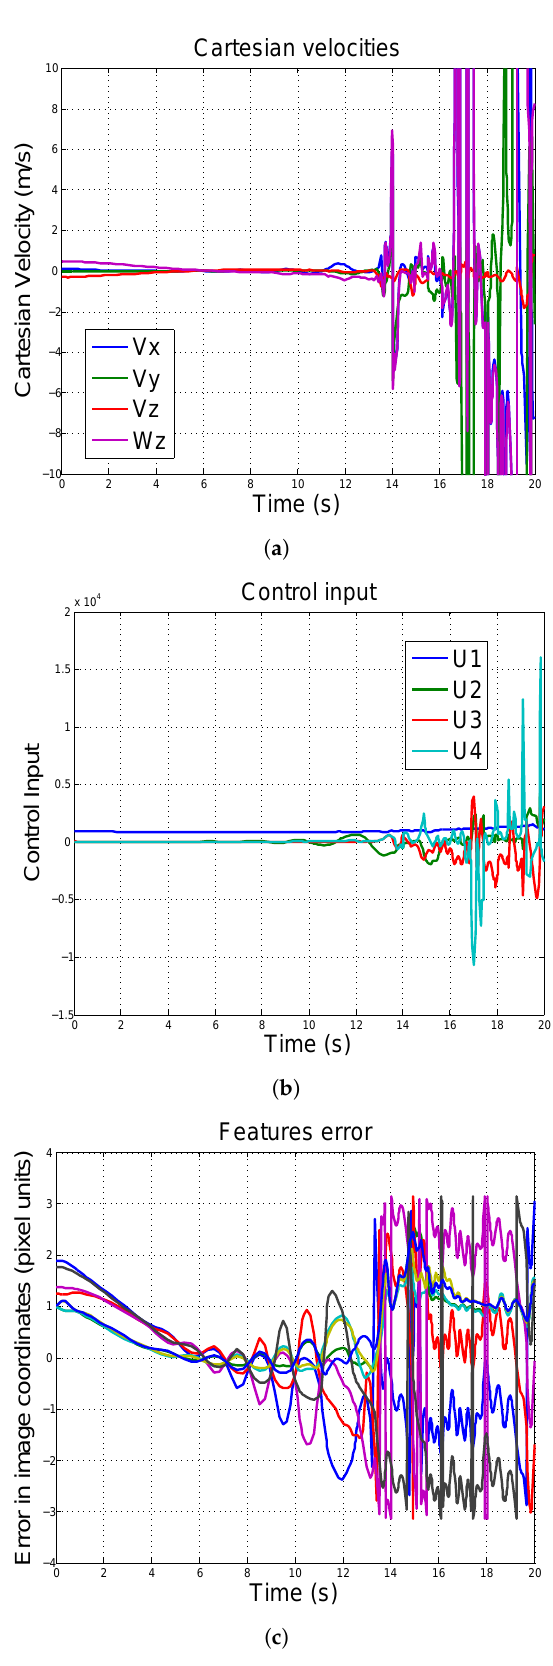
Figure 7. Simulation using conventional PID. Moment of inertia is increased. Mass remains constant. It can be seen that the robot is not stable when I x changes. ( a ) Cartesian velocities; ( b ) control input; ( c ) features